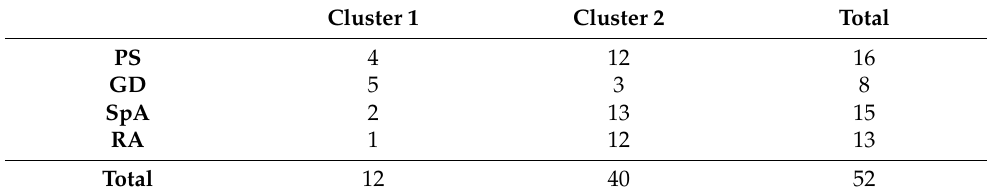
Table 4. miRNA clusters associated to VPAC2 expression are useful in determining the diagnosis. Cluster